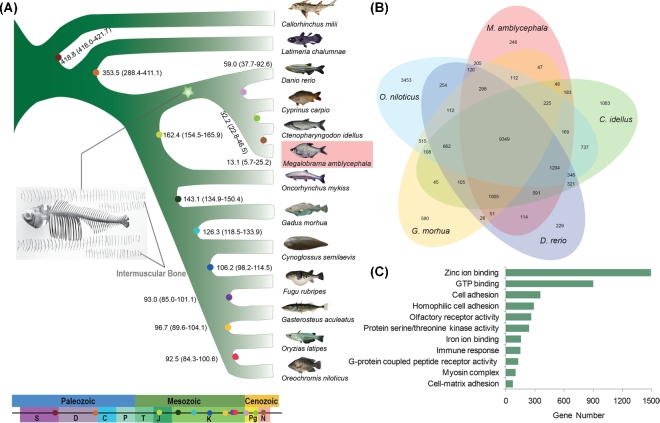
Phylogenetic tree and comparison of orthologous genes in M. amblycephala and other fish species. (A) Phylogenetic tree of teleosts using 316 single copy orthologous genes. The color circles at the nodes show the estimated divergence times using O. latipes–F. rubripes (96.9∼150.9 Mya), F. rubripes–D. rerio (149.85∼165.2 Mya), F. rubripes–C. milii (416∼421.75 Mya; http://www.timetree.org/) as the calibration time. The pentagram represents 4 cyprinid fish with intermuscular bones. S: Silurian period; D: Devonian period; C: Carboniferous period; P: Permian period in Paleozoic; T: Triassic period; J: Jurassic; K: cretaceous period in Mesozoic; Pg: Paleogene in Cenozoic Era; N: Neogene. (B) Venn diagram of shared and unique orthologous gene families in M. amblycephala and 4 other teleosts. (C) Over-represented GO annotations of cyprinid-specific expansion genes.